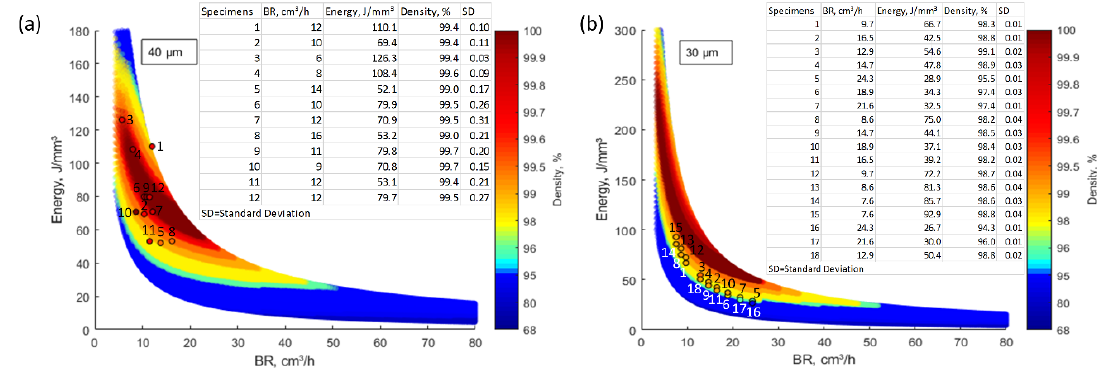
Figure 7. Processing maps for ( a ) Fe and ( b ) AlSi10Mg.